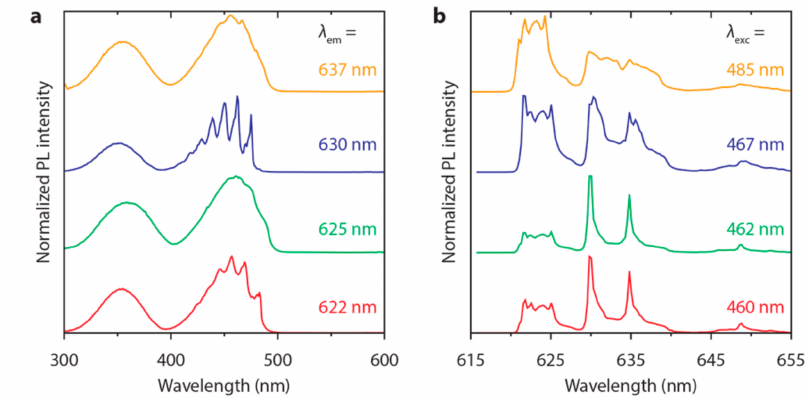
Figure 5. Emission and excitation spectra of K 2 NaAlF 6 :Mn 4+ (0.9%) at T = 4 K. ( a ) Excitation spectra for λ em = 622 nm (red), 625 nm (green), 630 nm (blue) and 637 nm (orange); ( b ) Emission spectra for λ exc = 460 nm (red), 462 nm (green), 467 nm (blue) and 485 nm